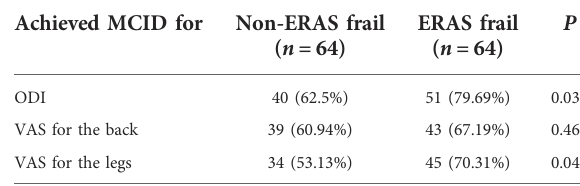
TABLE 3 Clinical ef fi cacy described by recovery for the Oswestry Disability Index and visual analog score according to the minimal clinically important difference between